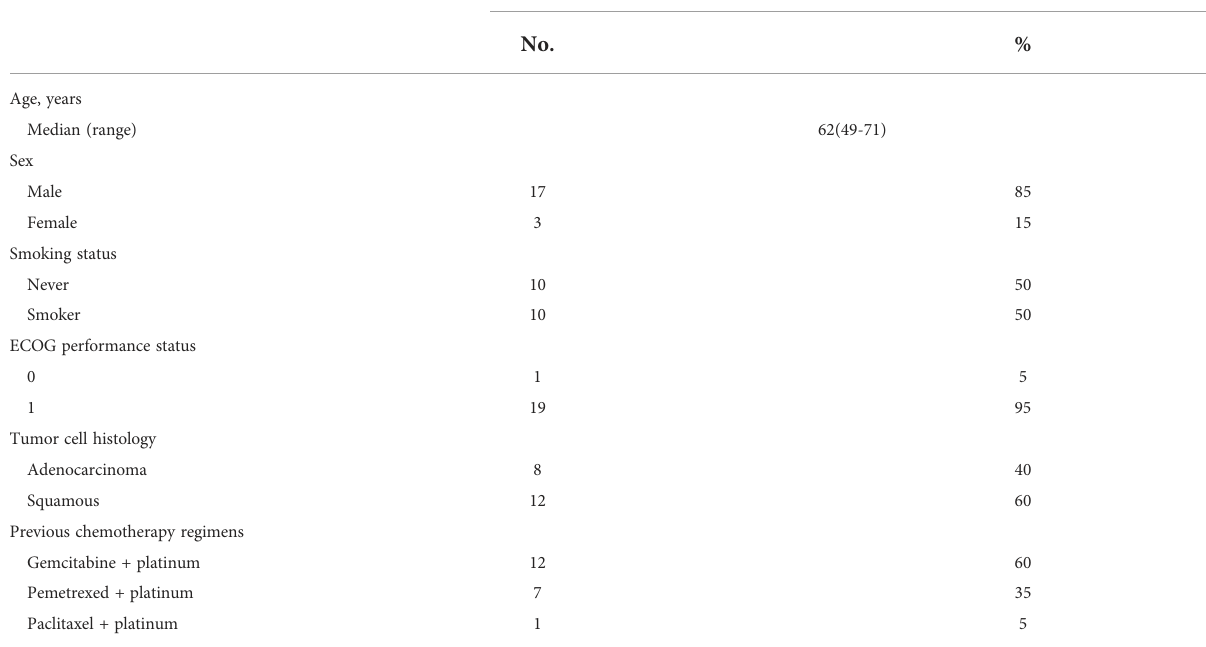
TABLE 1 Baseline characteristics and prior therapy of all treated patients with NSCLC.